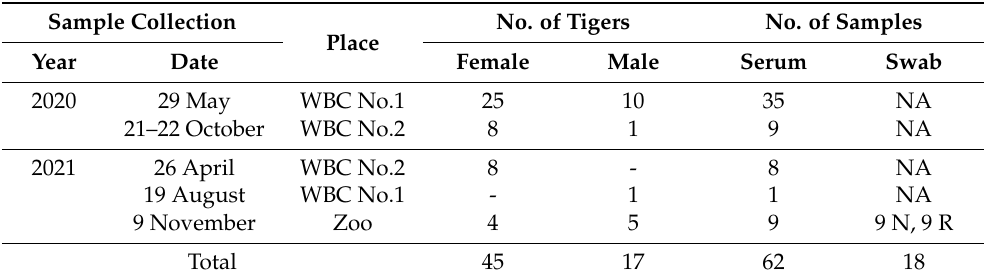
Table 1. Demographic characteristics of samples derived from captive adult tigers during 2020–2021, Ratchaburi province,